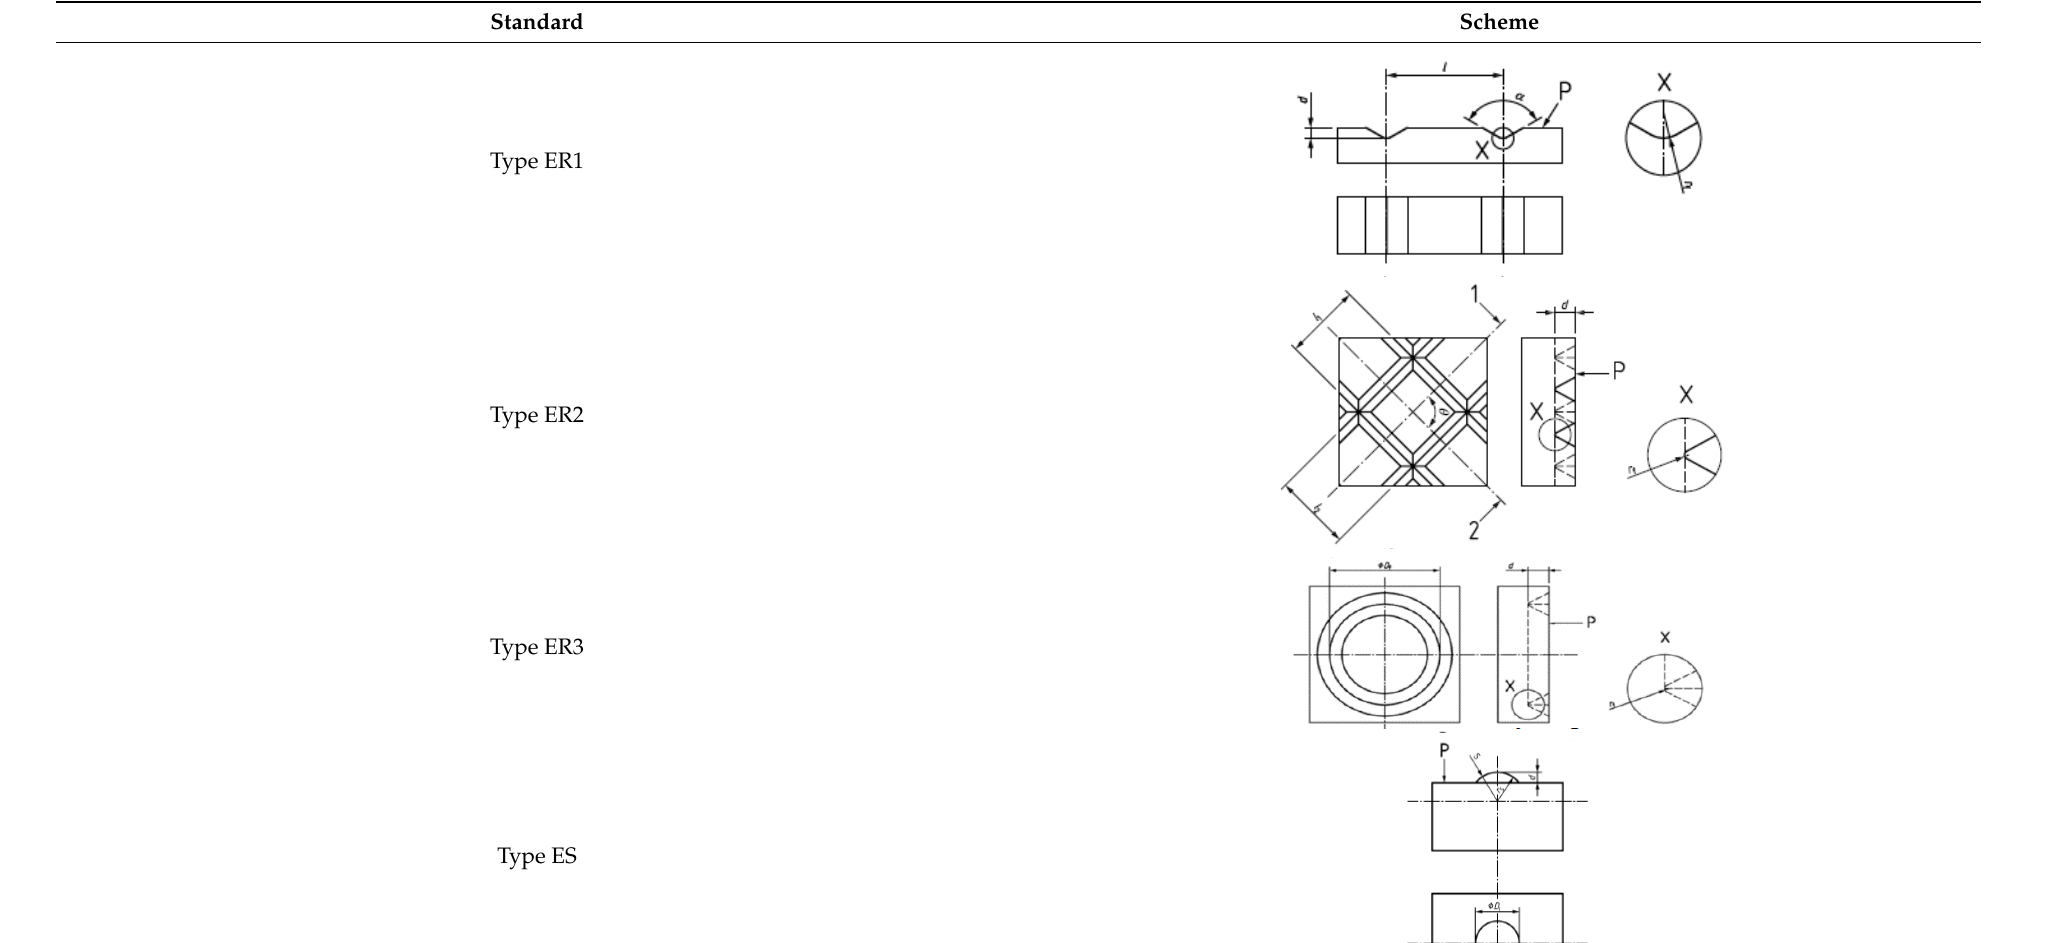
Table 3. Areal surface texture artifacts according to ISO 25178-701 [1,40].